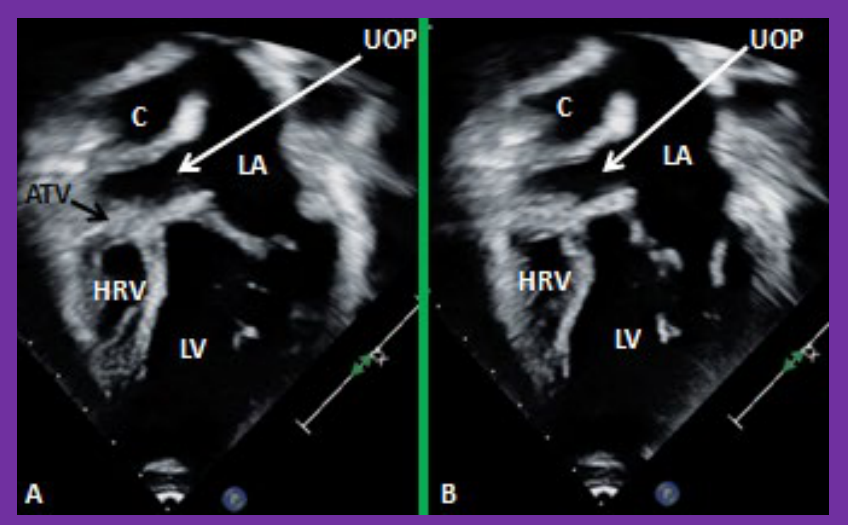
Figure 40. Selected video frames from apical four-chamber views demonstrating unobstructed pathway (UOP) (long arrow) between the right and left (LA) atria; the mitral valve is closed in ( A ) while it is open in ( B ). ATV, atretic tricuspid valve; C, conduit; HRV, hypoplastic right ventricle; LV, left ventricle.